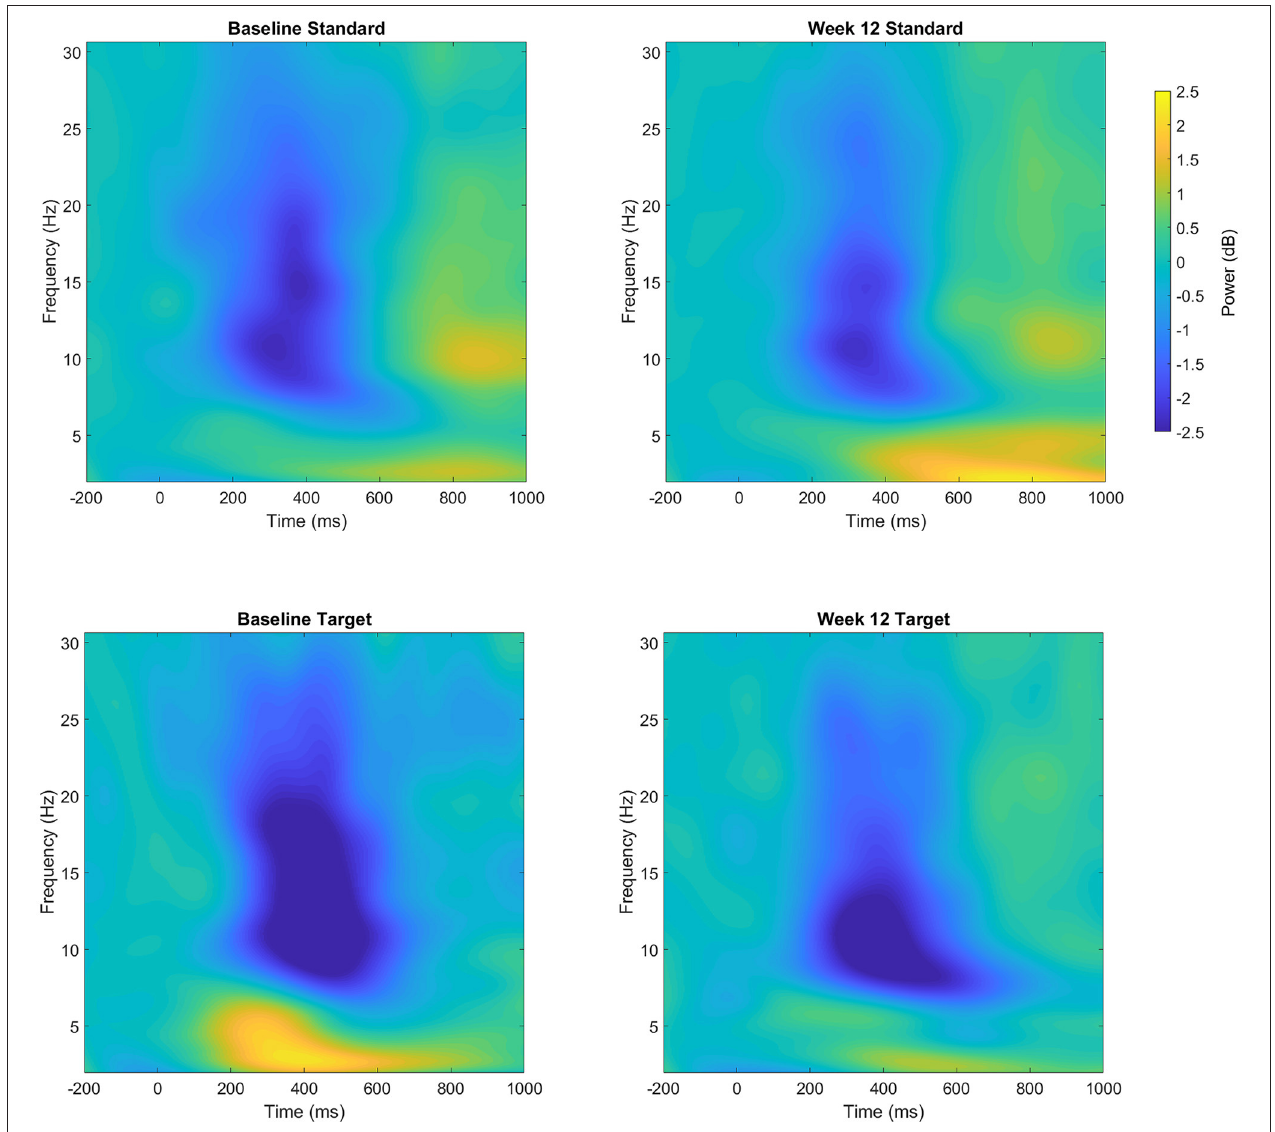
FIGURE 2 | Event-related power (dB) at both Baseline and Week 12 following standard (top row) and target (bottom row) trials over the parietal cluster. Changes in power reflect increases or decreased magnitude compared to the pre-stimulus baseline.